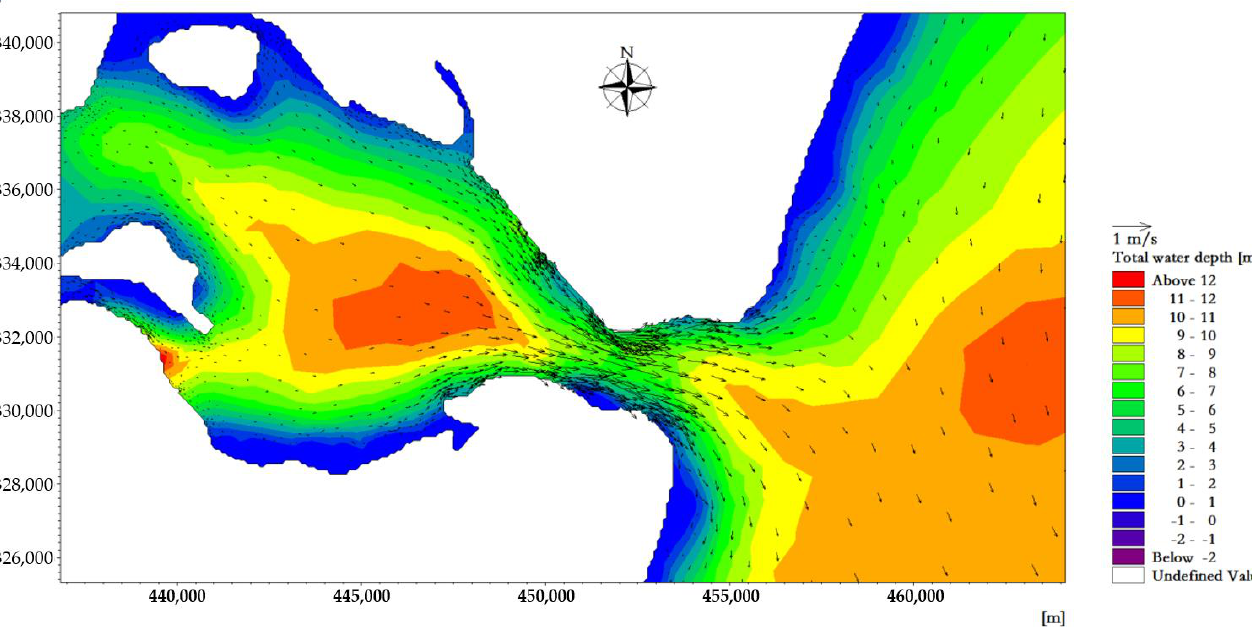
Figure 9. Flow field vertical distribution near the tidal inlet at the moment when the velocity of the flood tide reaches its maximum.